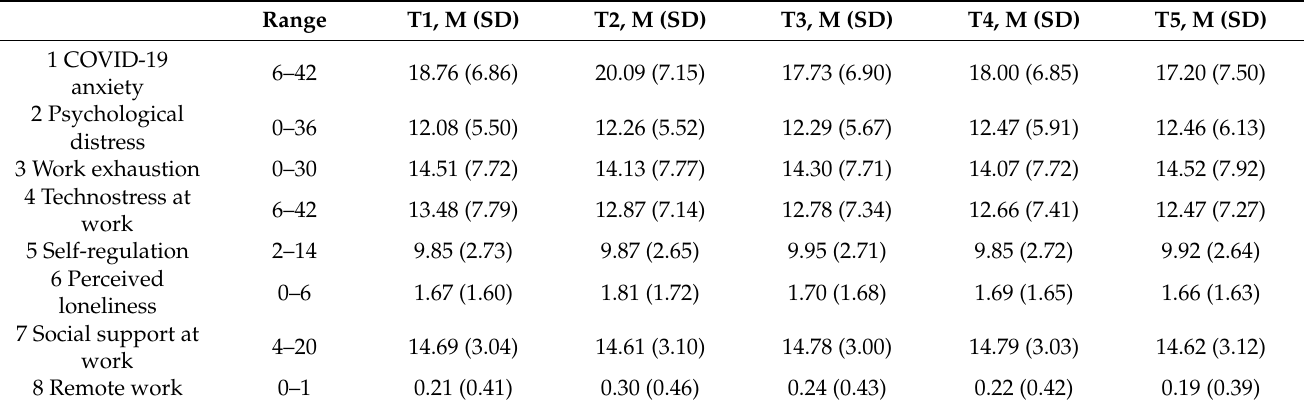
Table 1. Descriptive statistics of the main study